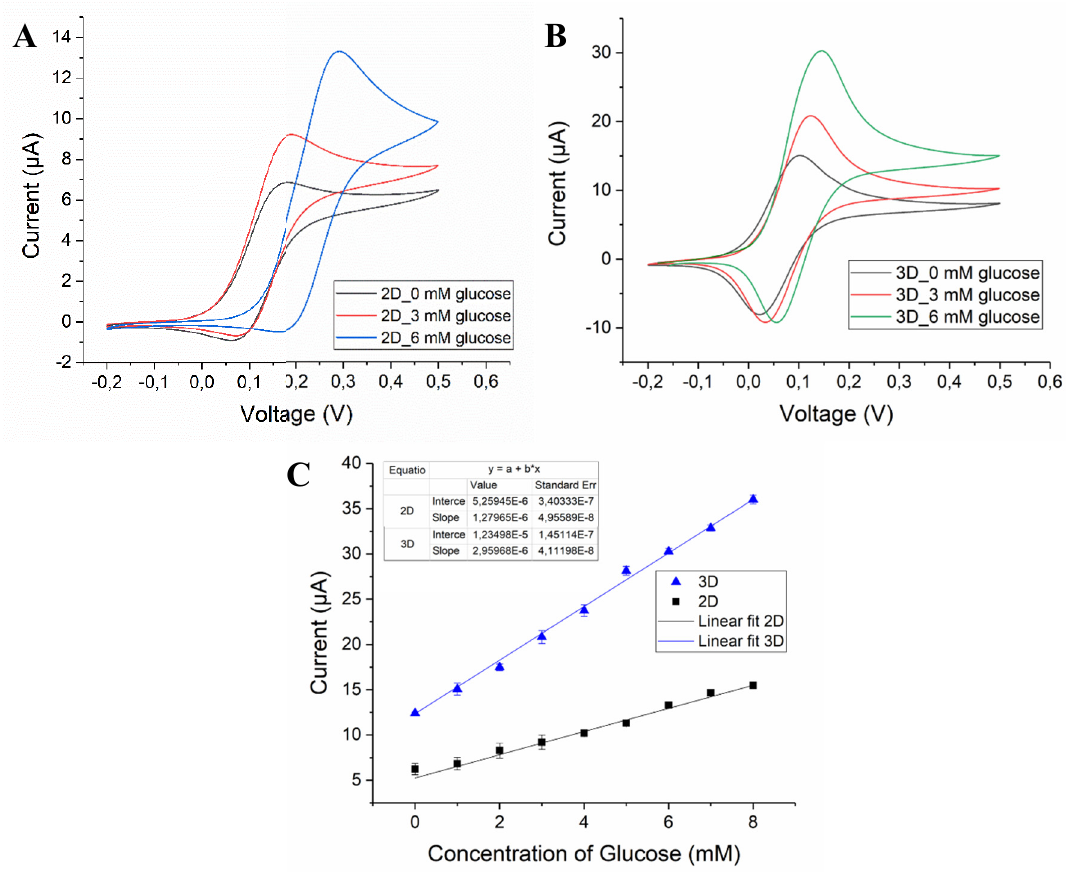
Figure 3. Cyclic voltammogram of ( A ) 2D/RGO-PEI/GOx and ( B ) 3D/RGO-PEI/GOx carbon electrodes in 10 mM PBS (pH 7), 3 mM glucose and 6 mM glucose at scan rate of 20 mV/s. ( C ) Corresponding calibration plot obtained from the concentration of glucose vs. current (N = 3).